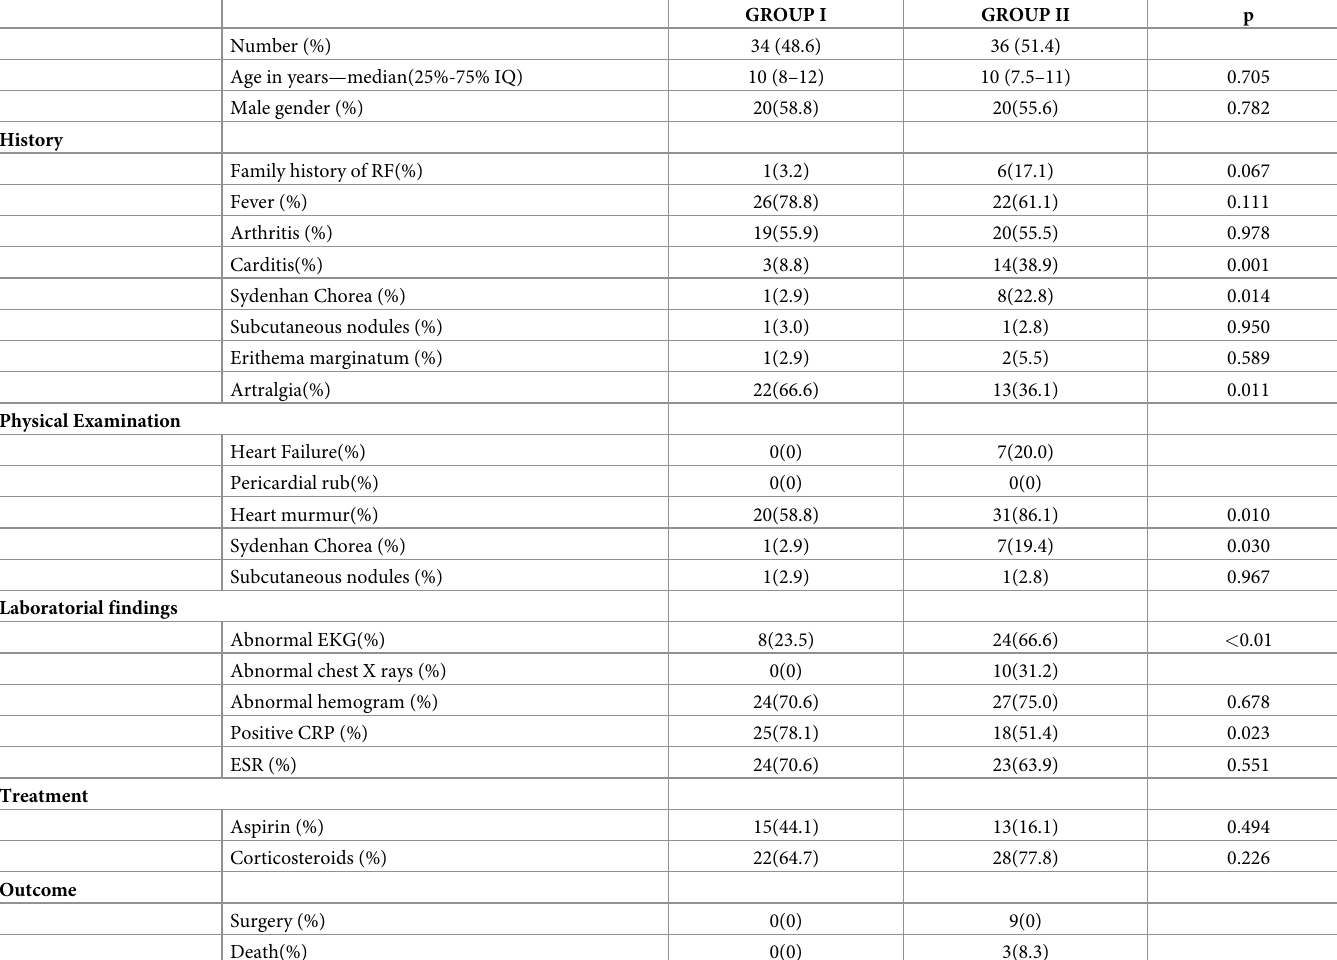
Table 1. Anthropometric, Jones criteria, clinical and laboratorial variables in according to the presence (Group II) or absence (Group I) of Rheumatic Heart Disease at the end of the